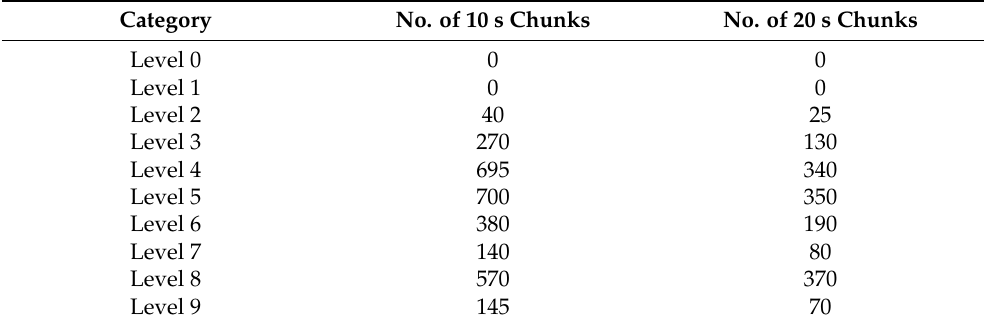
Table 4. Distribution of data among different aphasia severity levels for 10 s chunks and 20 s